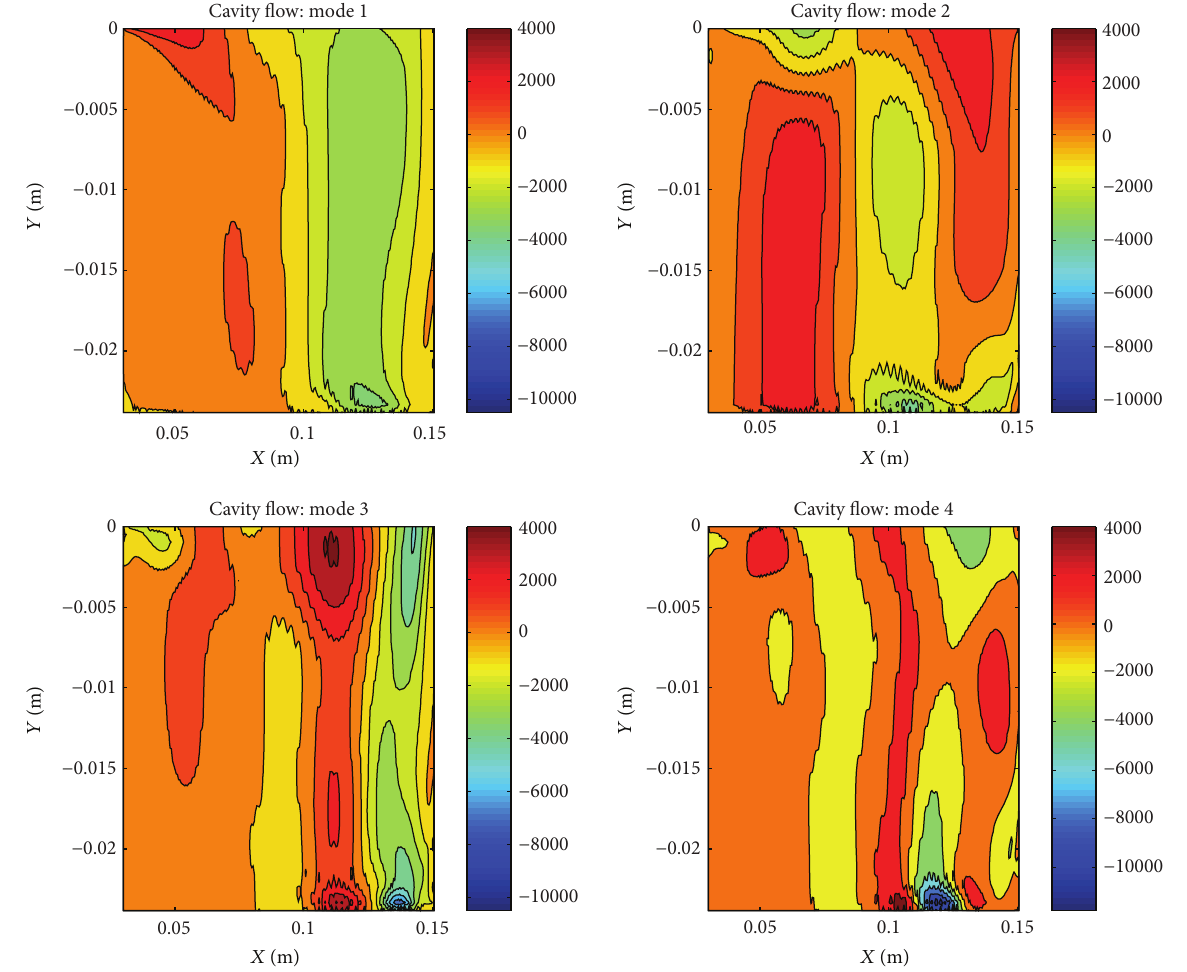
Figure 12: POD modes of cavity flow with L/D ratio of